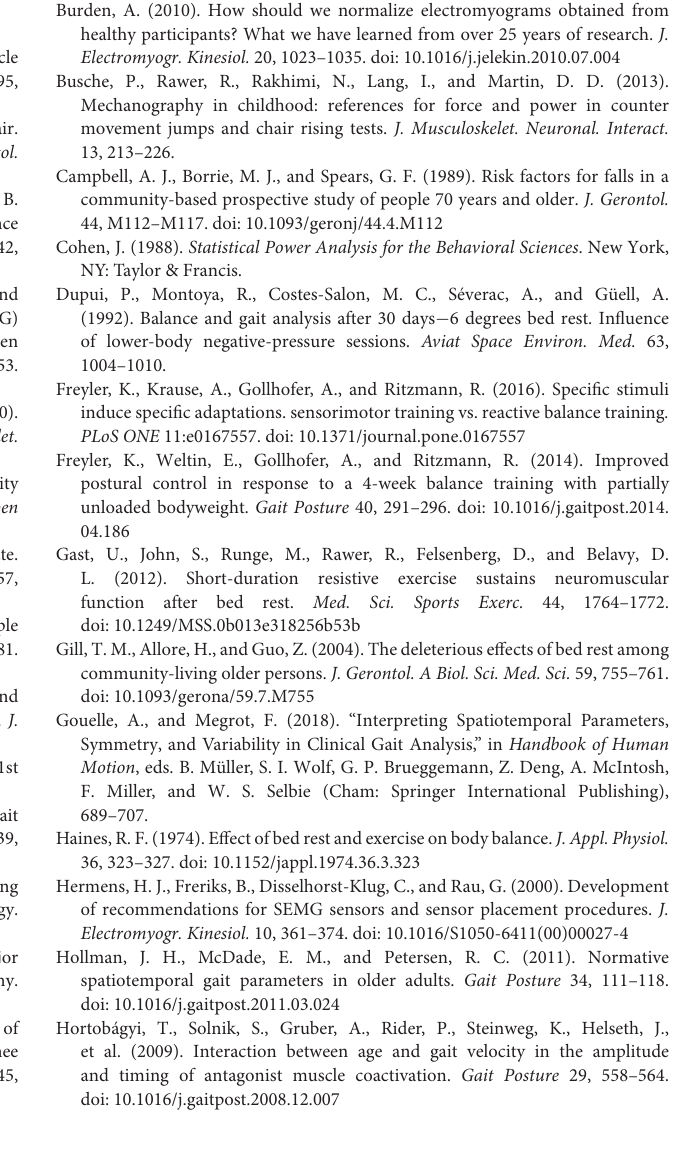
Figure and tables. RR, KF, AK, MG, DB, AG. GA: Review